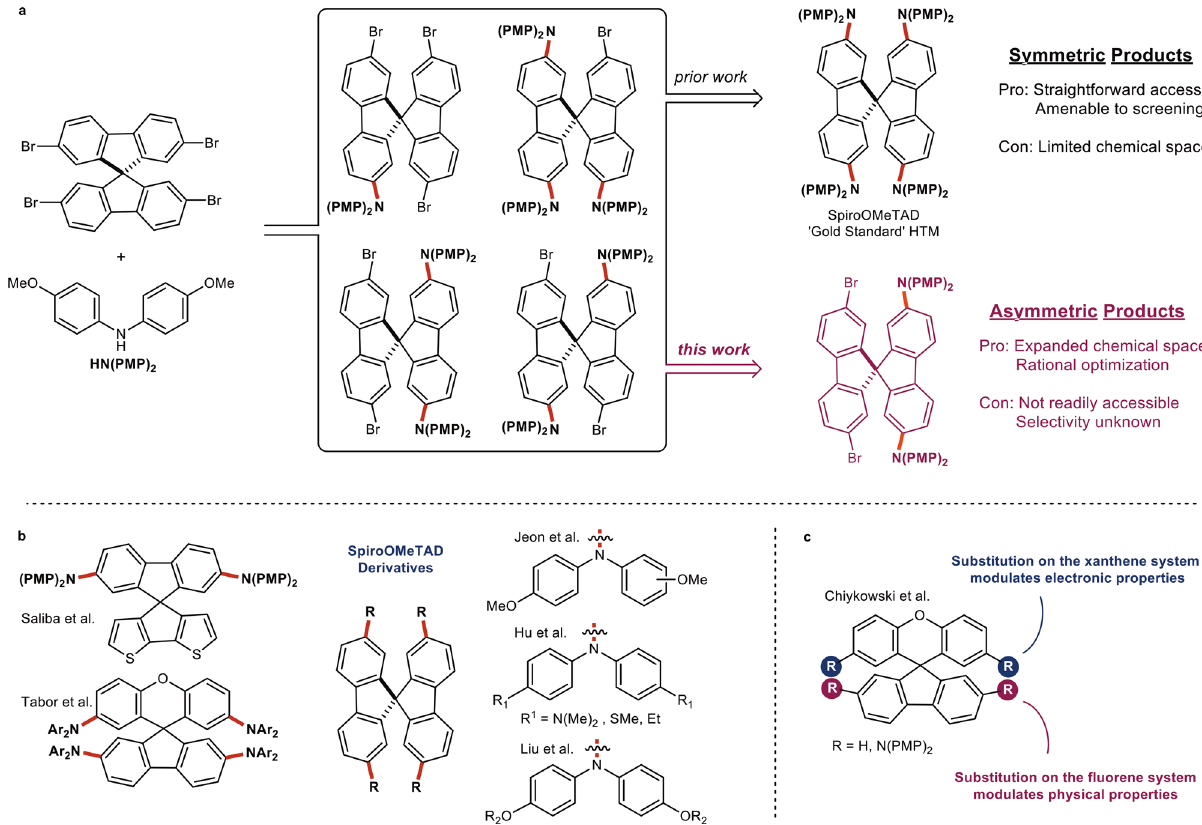
Fig. 1 Importance of asymmetric hole transport derivatives. a Standard synthetic procedure providing access to SpiroOMeTAD. b Examples of typical derivatives of SpiroOMeTAD. c In fl uence of substitution pattern on the resulting electronic and physical properties 16 . HTM = hole transport